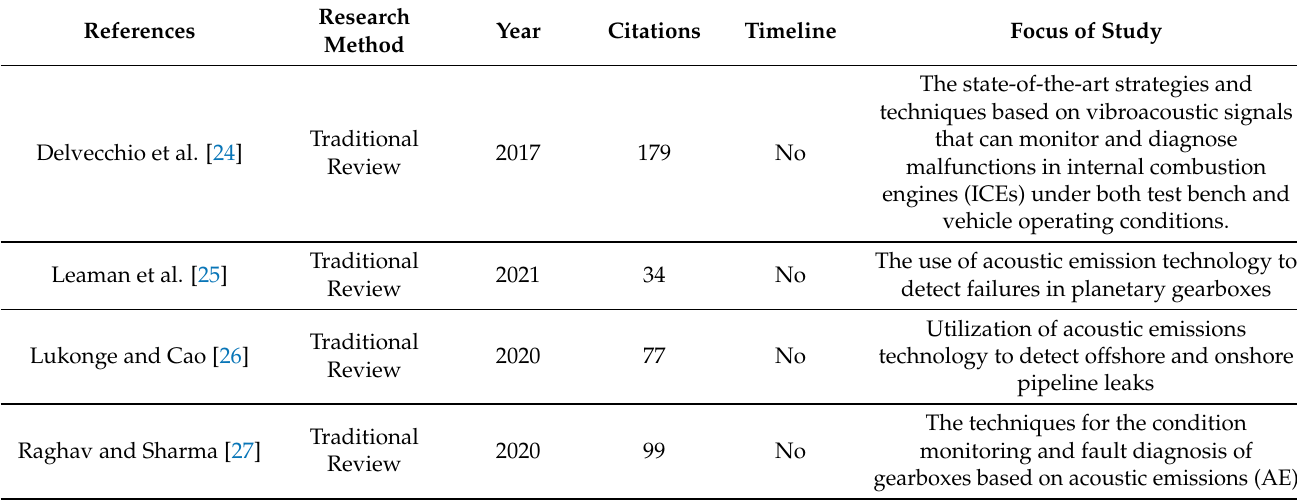
Table 1. Comparison of related